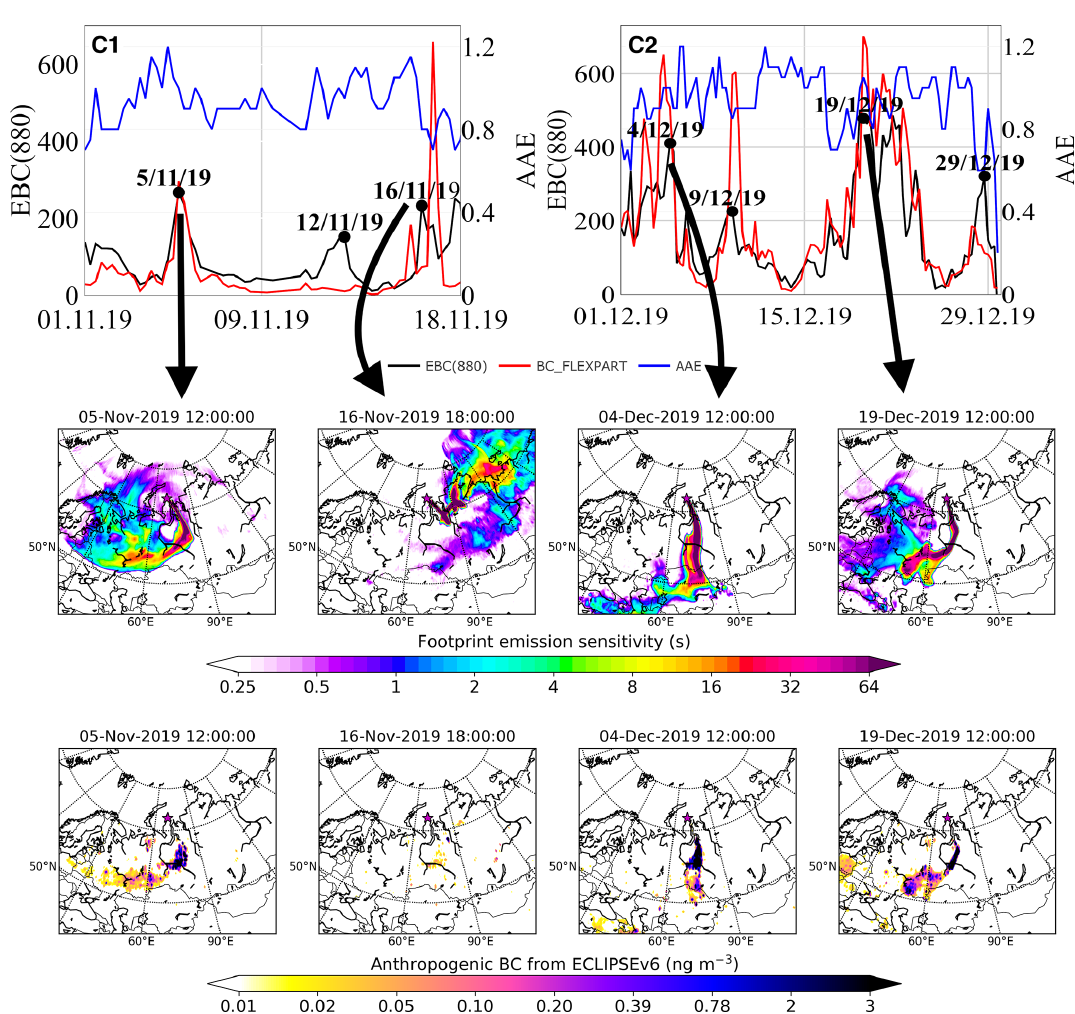
Figure 7. Examples of pollution episodes C1 and C2 observed in the cold period (see Fig. 5a), during which FLR contribution prevails. The 6h median EBC(880) (black line), BC simulated with FLEXPART (red line) and AAE (blue line) (upper row) values. Footprint emission sensitivities in seconds showing the largest probability of emission origin (middle row). Spatial distribution of anthropogenic contribution (in ngm − 3 ) to surface BC at the Island Bely station (bottom